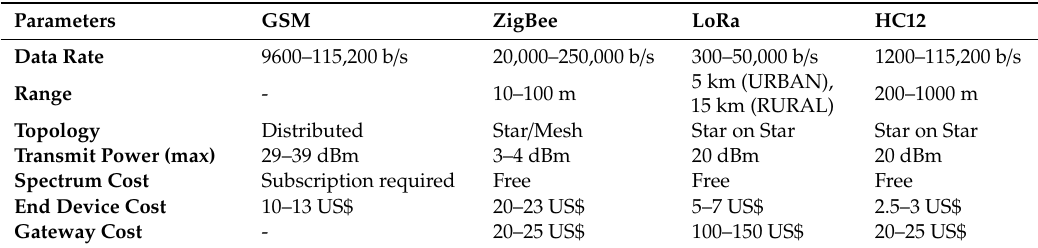
Table 5. Detailed comparisons of the proposed module with existing technologies